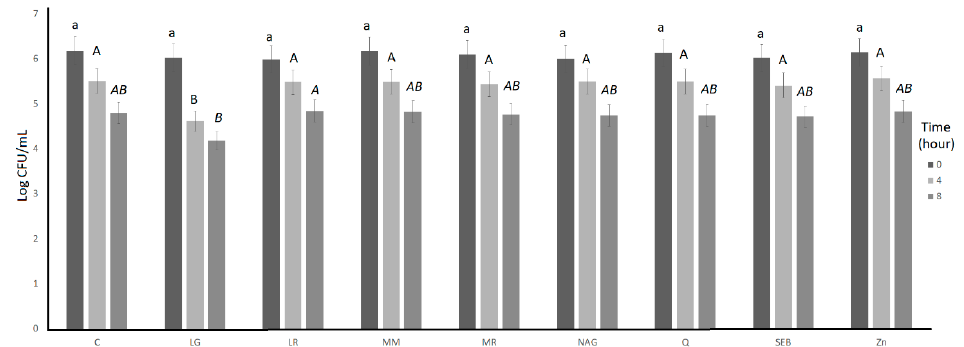
Figure 4. Log counts of Lactobacillus bulgaricus showing its bile tolerance as in fl uenced by ingredients over 8 h. C = control, LG = L-glutamine (7 g/L), Q = quercetin (700 mg/L), SEB = slippery elm bark (210 mg/L), MR = marshmallow root (1340 mg/L), NAG = N-acetyl-D-glucosamine (210 mg/L), LR = licorice root (210 mg/L), MM = maitake mushrooms (42 mg/L), and ZN = zinc orotate (70 mg/L). Average of three replicates. a : Values with different letters at 4 h are significantly different ( p < 0.05). A There were no significant ( p > 0.05) differences at 0 h. A,B, Values with different letters at 4 h are significantly different ( p < 0.05). A,B Values with different letters at 8 h are significantly different ( p < 0.05). Error bars represent